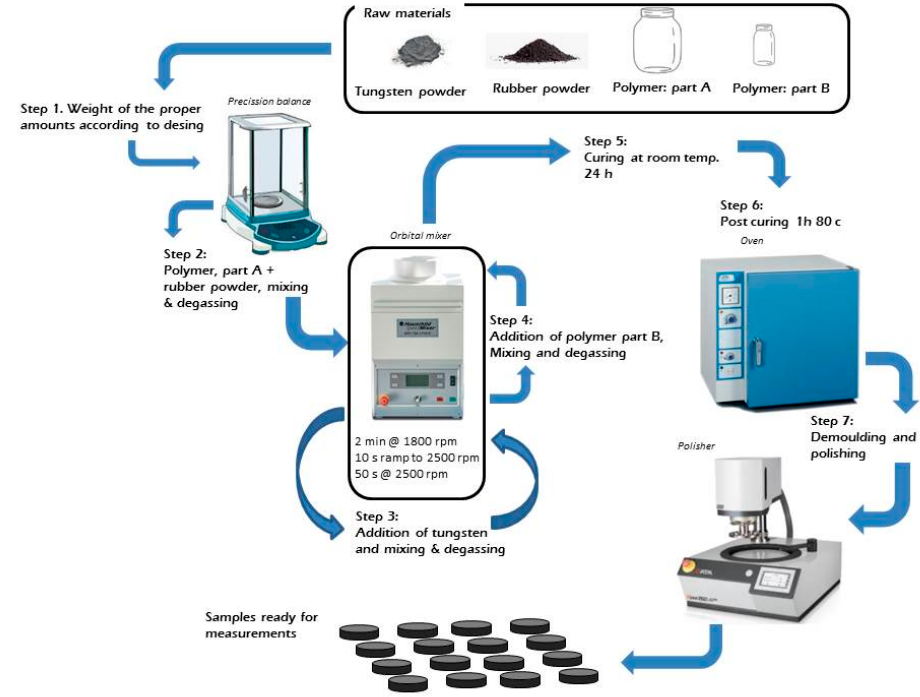
Figure 2. Schematic diagram of the fabrication procedure.